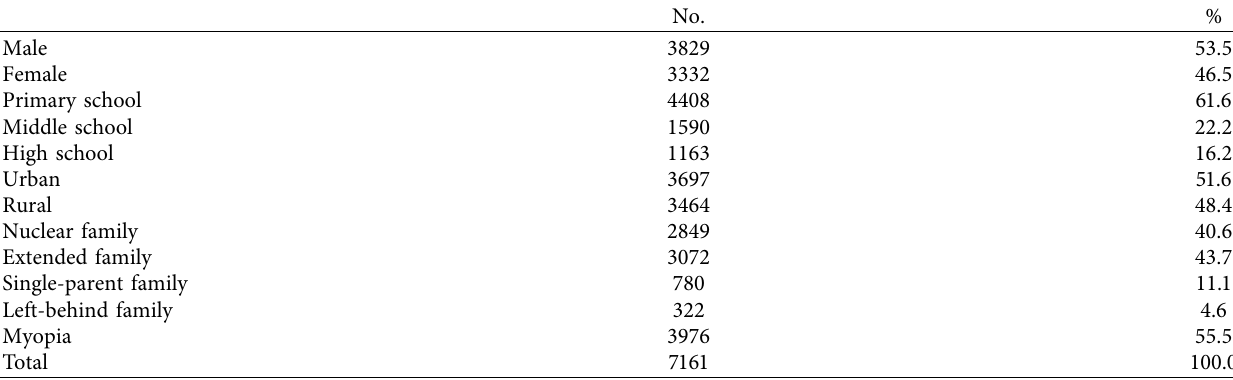
Table 1: Demographic characteristics of the study of the Chinese children and adolescents. No.